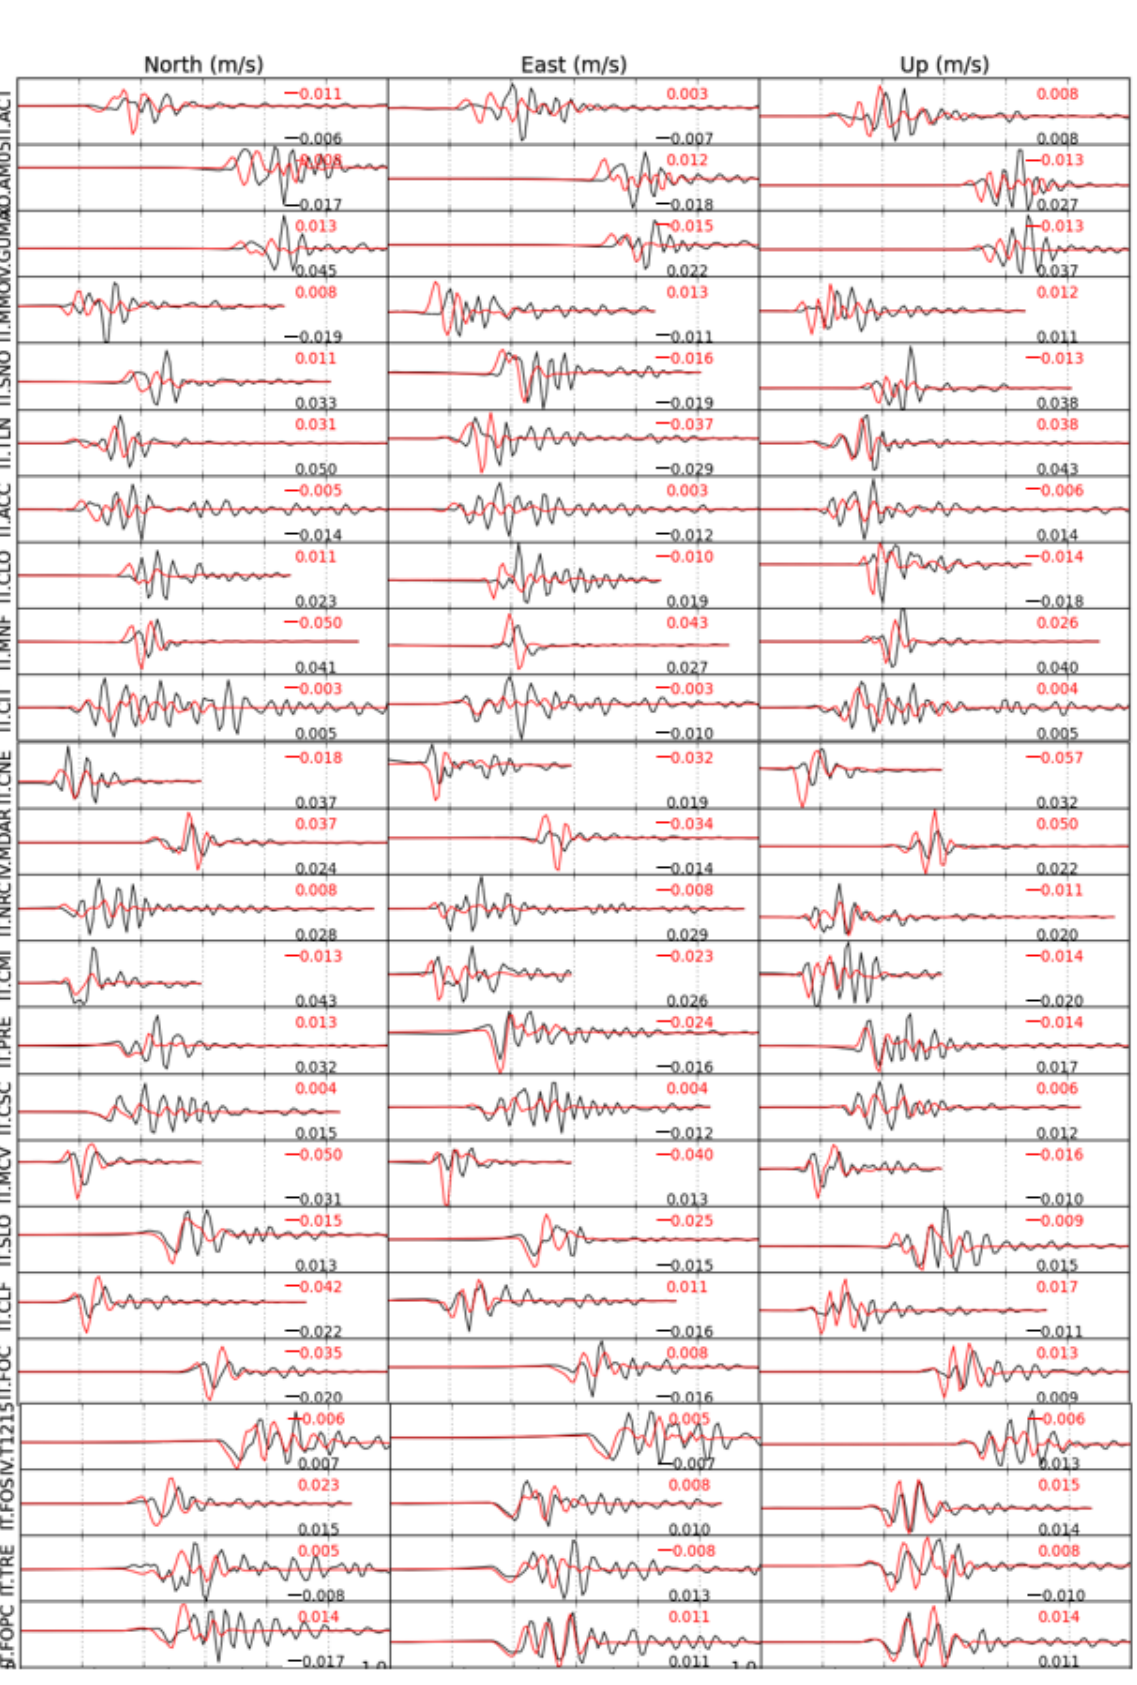
Figure A8. Comparison of strong-motion velocity records (black) and the synthetic seismograms (red) predicted by the joint slip model of the Visso earthquake.